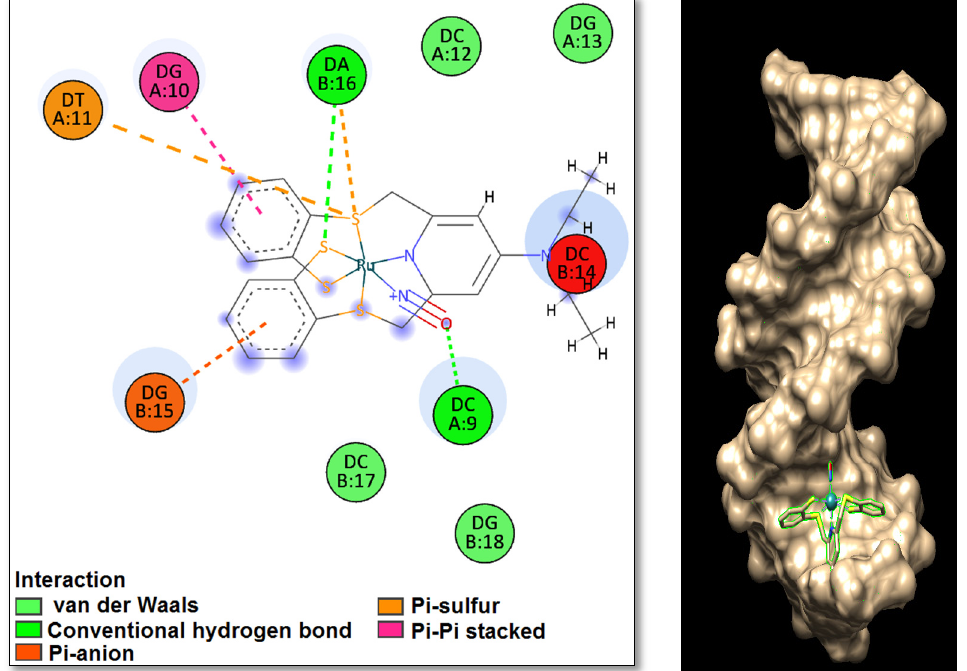
Figure 13. Different types of interactions between [RuNOTSP] + and DNA bases as in the first view to the left while in the second view display [RuNOTSP] + docked to the major groove of DNA fragment (2L8i).